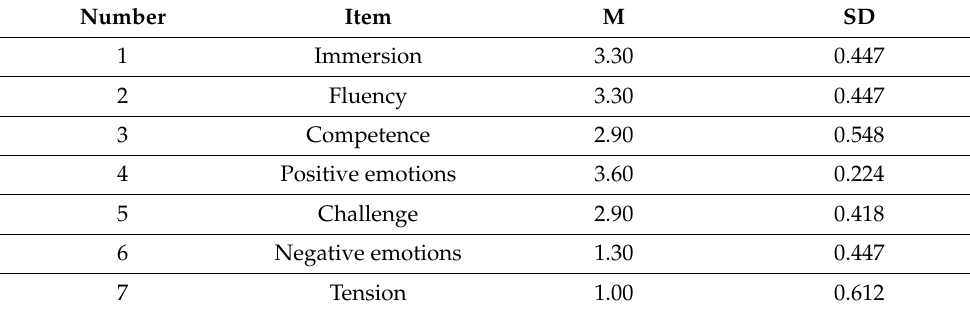
Table 7. The score of each dimension of the game experience scale.